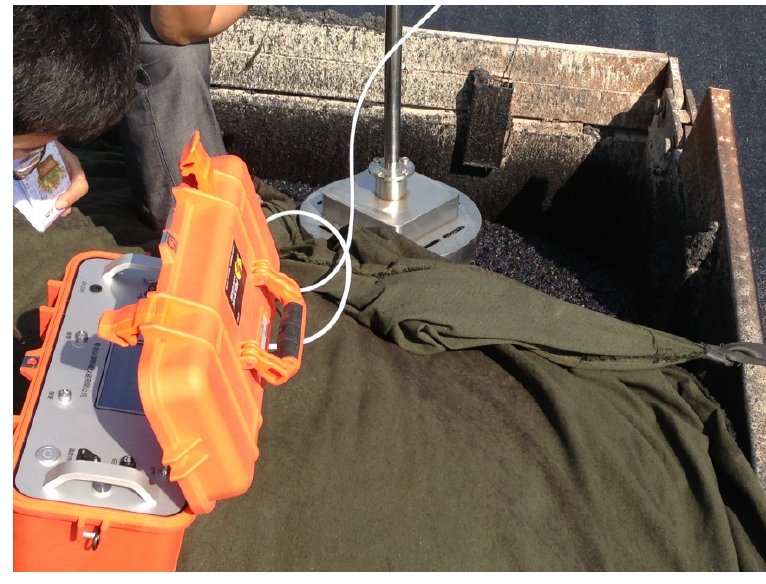
Figure 4. The field testing of GHG emission in transportation phase.